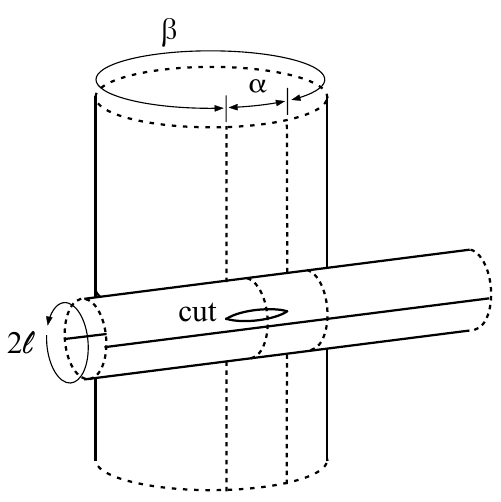
Figure 12 . Doubled holomorphic representation of the (cid:13)ag-anti-(cid:13)ag